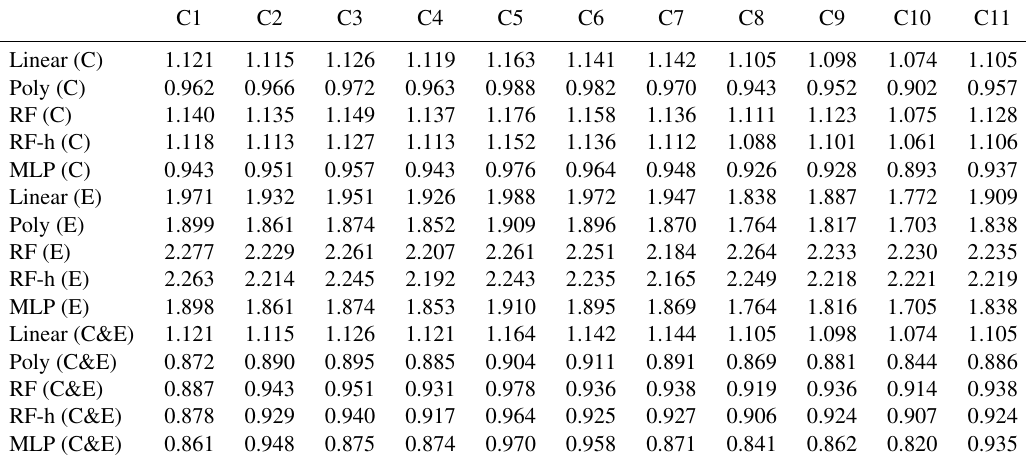
Table A3. RMSE (in ppm) for the different configurations of subsetting based on the selected clusters of peaks. Only Figaro ® sensors were used to compute this error. Each configuration is denoted “CX”, with X being the number of the configuration. In each row, the models are denoted with a letter inside parentheses to indicate the sensors used. “C” denotes the TGS 2611-C00, “E” the TGS 2611-E00 and “C&E” both